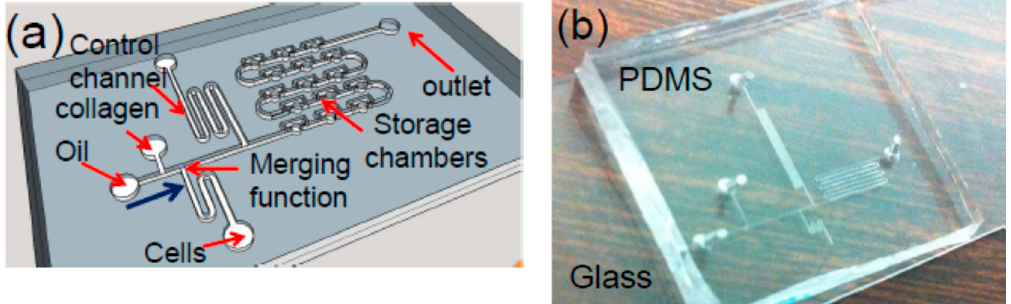
Figure 1. ( a ) Sketch of the droplet microfluidic chip for generating 3D microtissues ( not to scale ): Each storage chamber (a cylinder with a radius of 60 µm and height of 50 µm) has one 3D microtissue containing single or multiple cells; ( b ) Photo of a fabricated chip with 75 storage chambers.